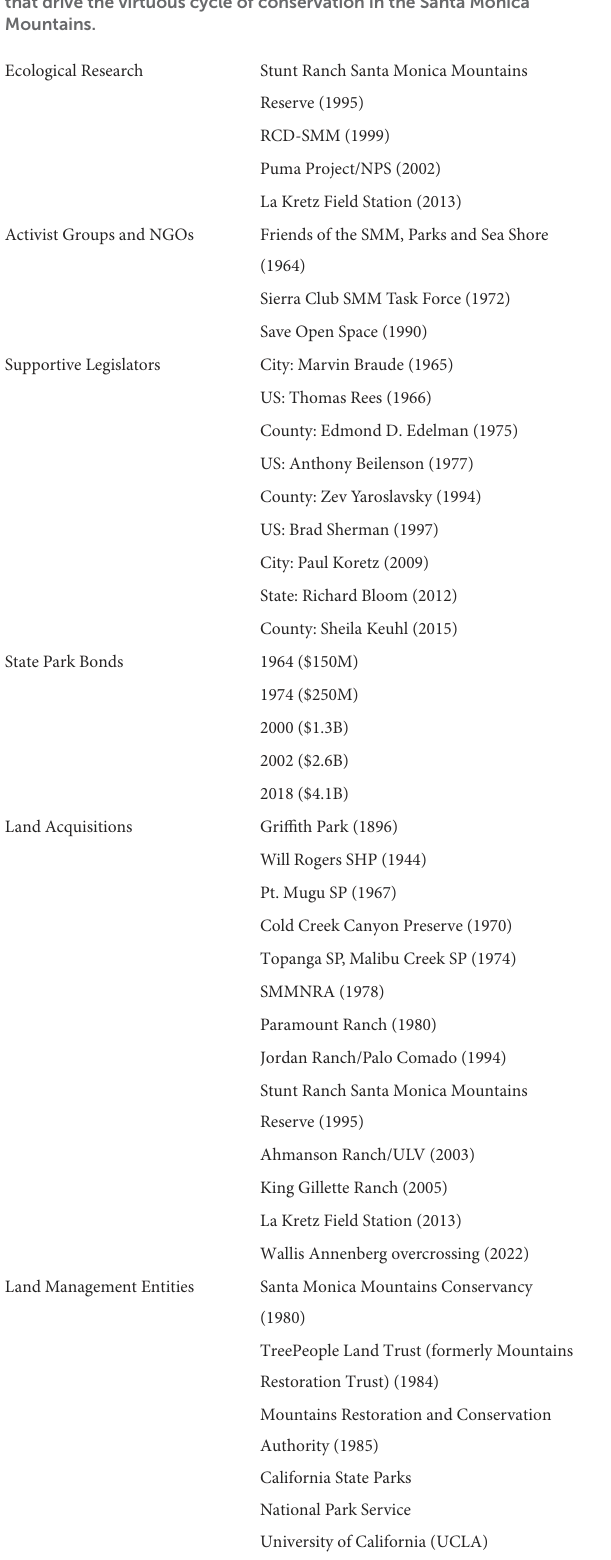
TABLE 1 Notable examples within each major stakeholder category that drive the virtuous cycle of conservation in the Santa Monica